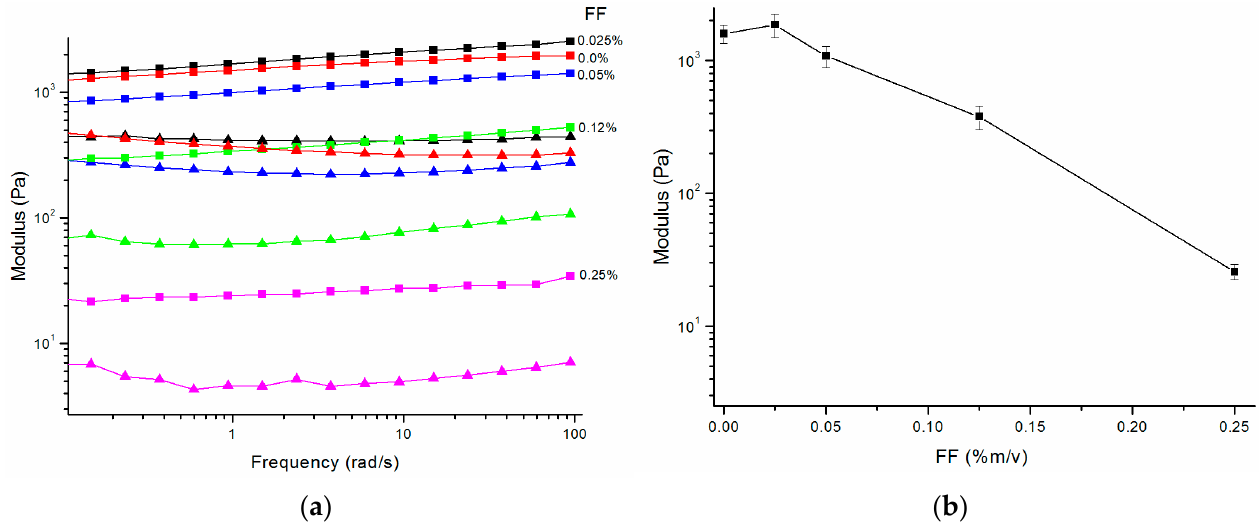
Figure 10. Rheology of hydrogels of 1%P5 ( w / v ) with different concentrations of FF nanotubes. ( a ) Dynamic frequency sweep at 0.2% of strain of HF1 ( black ), HF2 ( blue ), HF3 ( green ), and HF4 (ma- ( a ) Dynamic frequency sweep at 0.2% of strain of HF1 (black), HF2 (blue), HF3 (green), and HF4 genta ) hydrogels. Square ( ■ ) symbols report storage moduli (G’), while triangle ( ▲ ) symbols report (magenta) hydrogels. Square ( (cid:4) ) symbols report storage moduli (G’), while triangle ( (cid:78) ) symbols report loss moduli (G”); ( b ) storage modulus (G’) at 0.2% strain and 9.4 rad s − 1 as a function of concentration of FF